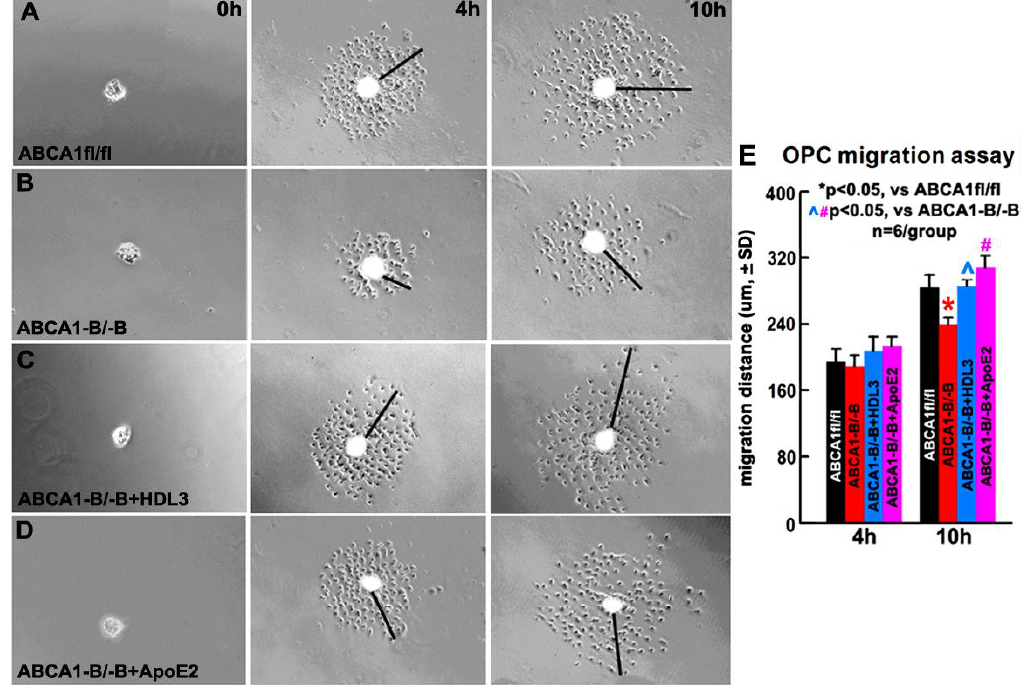
Figure 6. ABCA1 -B/-B -OPCs exhibit decreased migration compared to ABCA1 fl/fl -OPCs in vitro, while the treatment of ABCA1 -B/-B -OPCs with HDL3 or ApoE2 reversed the reduction of migration. Images of OPC-sphere cultures in ABCA1 fl/fl – OPCs ( A ), ABCA1 -B/-B -OPCs ( B ), and ABCA1 -B/-B -OPCs treated with HDL3 ( C ) or ApoE2 ( D ). The quantitative data of OPC migration distance ( E ) were acquired at 4 h or 10 h, respectively. * p < 0.05, vs. ABCA1 fl/fl -OPCs; ^, # p < 0.05, vs. ABCA1 -B/-B -OPCs; n = 6 wells/group.